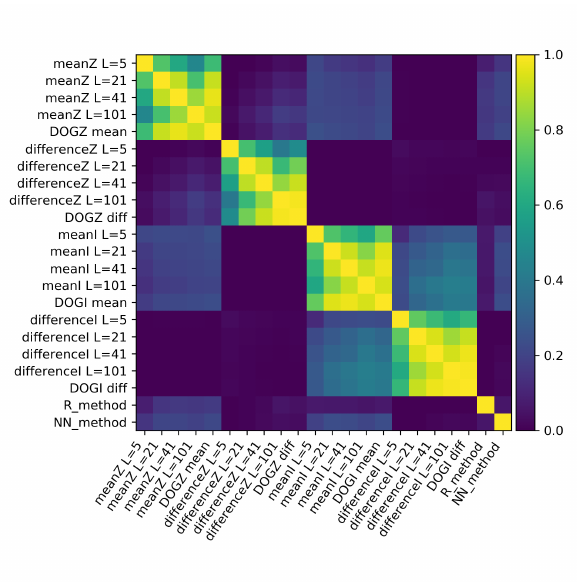
Figure 6. Correlation matrix of the features. L gives the window size which is used for calculating the